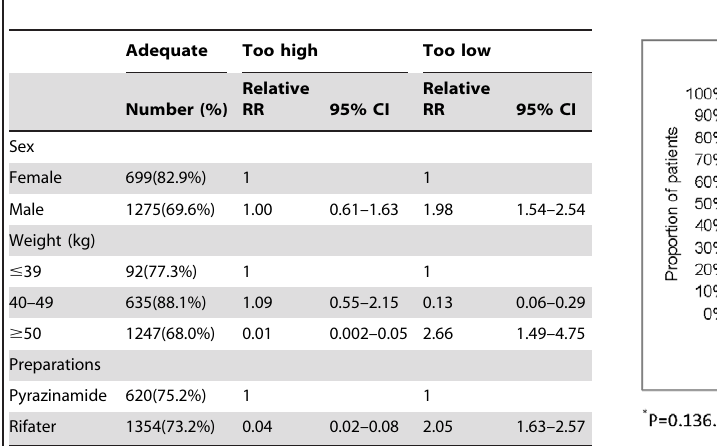
Table 4. Factors associated with inadequate dosing of pyrazinamide among patients treated with Rifater or pyrazinamide in single-drug preparation, 2007–2010, Taipei.